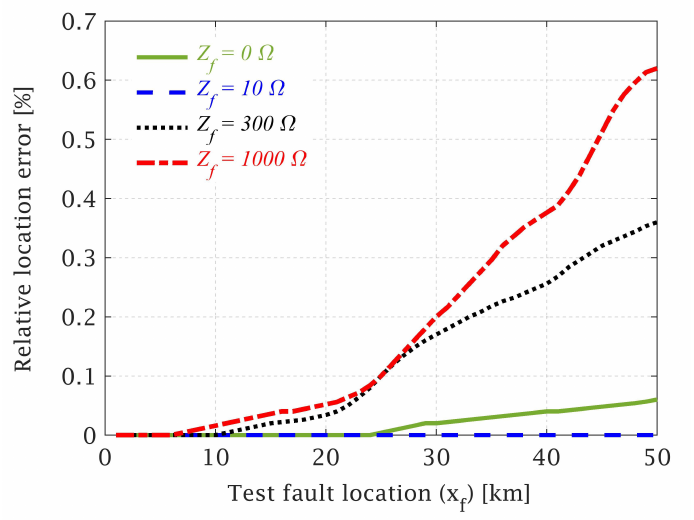
Figure 10. Impact of the fault impedance mismatch along the line length in terms of the relative location error; in the fault occurrence stage, four different values of fault impedance are considered, while in the fault estimation stage, Z f = 10 Ω .